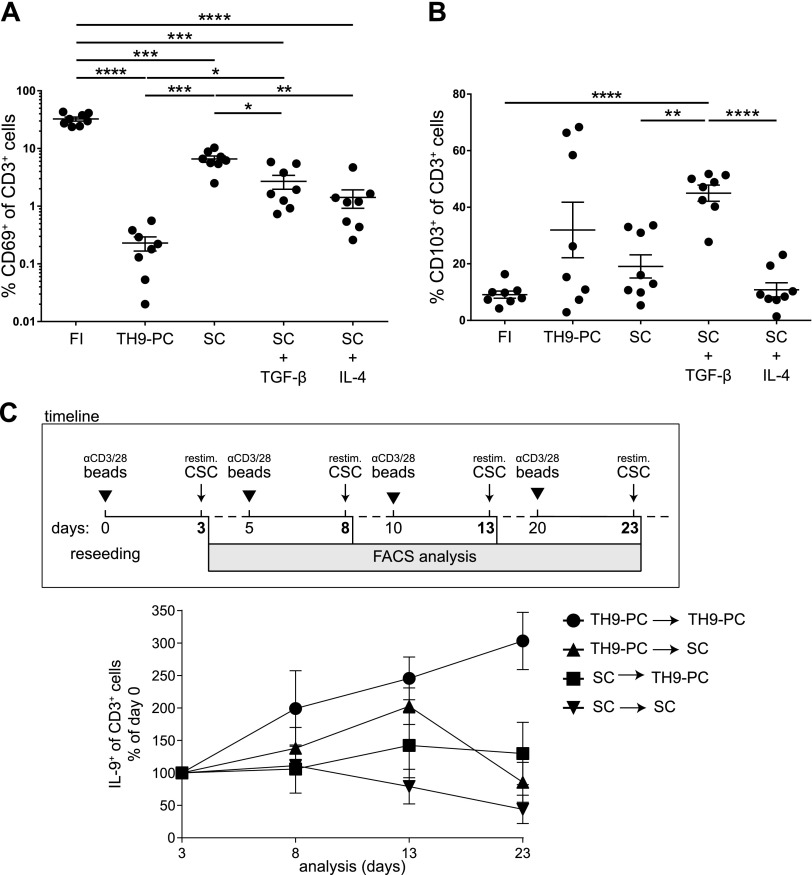
Culture conditions alter CD69 and CD103 expression on skin T cells. A, B) Percentage of CD69 and CD103 cells among skin T cells (FI) or harvested after 4 wk from skin explant cultures under indicated conditions. Paired data are means ± sem and were analyzed using repeated measures with 1-way ANOVA (Holm-Sidak post hoc). *P ≤ 0.05, **P ≤ 0.01, ***P ≤ 0.001, ****P ≤ 0.0001. Only significant differences are indicated. C) T cells from 4-wk cultures were reseeded (d 0; 105 T cells/well) and stimulated as well as restimulated according to the scheme. Percentage of IL-9+ T cells upon reseeding T cells under indicated conditions. Before each analysis, cells were αCD3 and αCD28 bead–stimulated and CSC-restimulated 3 d at the indicated time points (n = 3). Data are means ± sem.